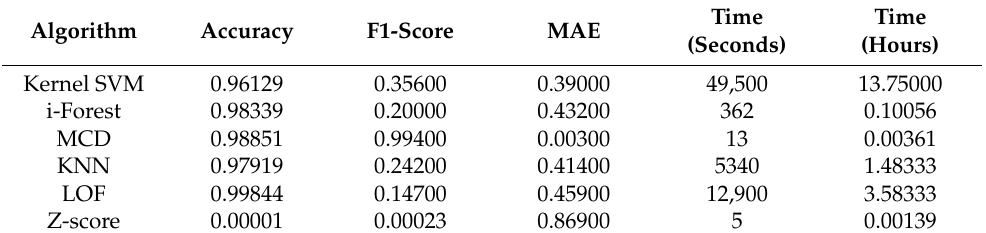
Table 4. Accuracy, F1-score, MAE, and execution time